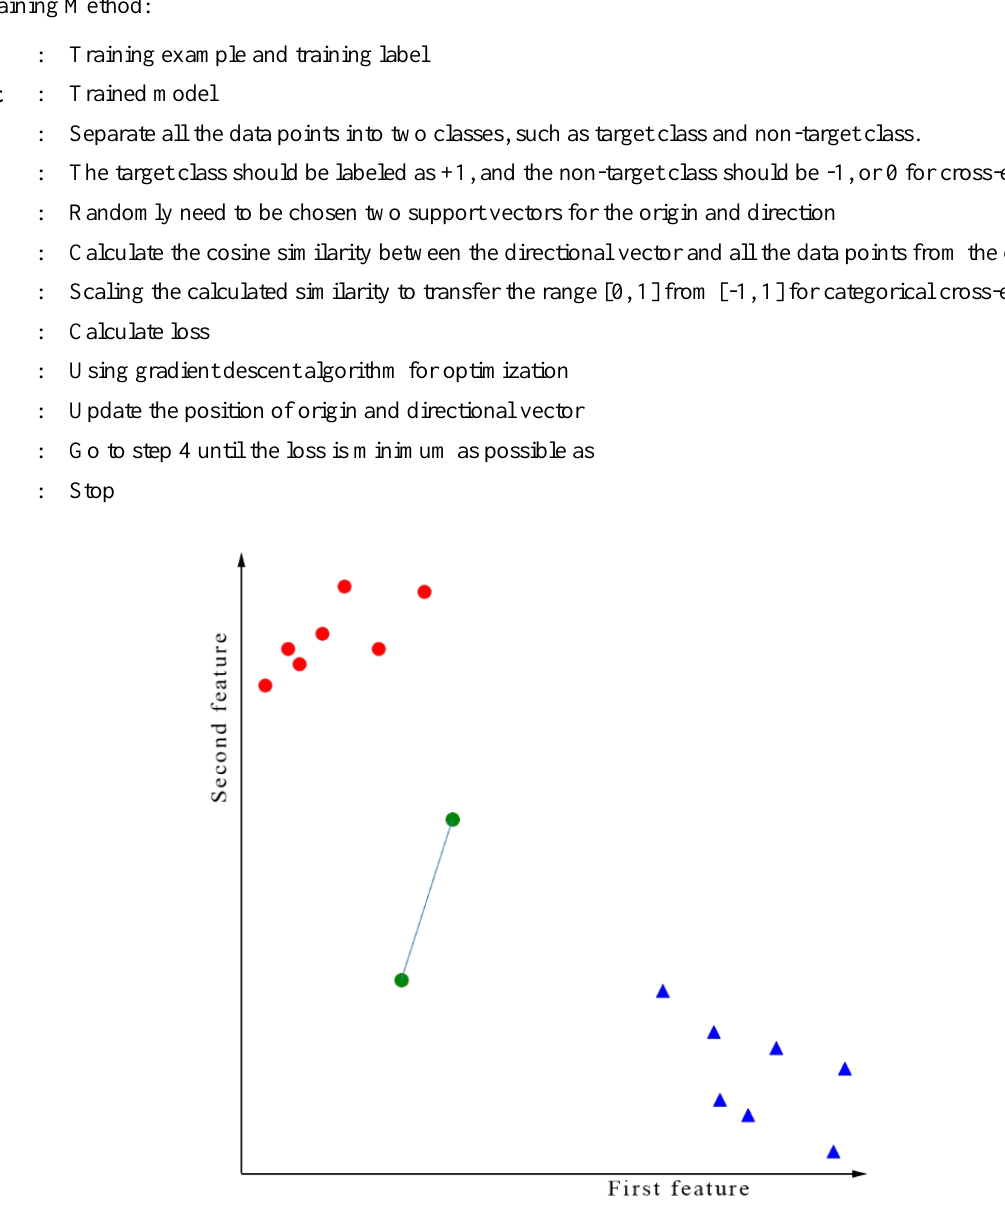
Figure 7. Random generation of shifting origin and shifting support direction vector in the first